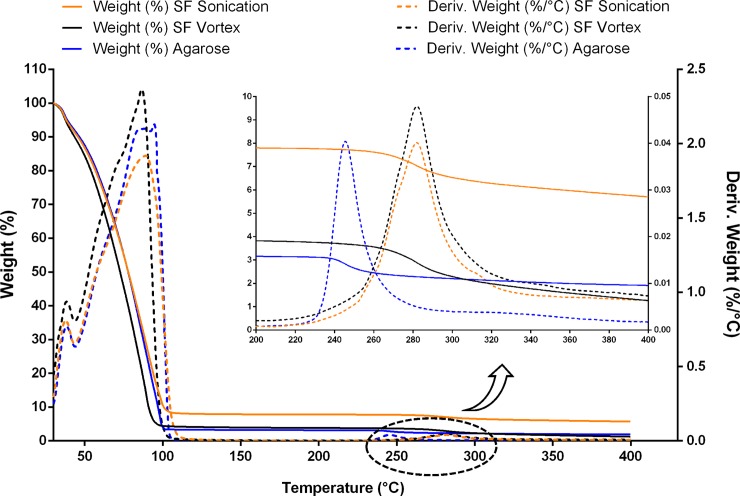
TGA and DTGA thermal analysis of hydrogels.